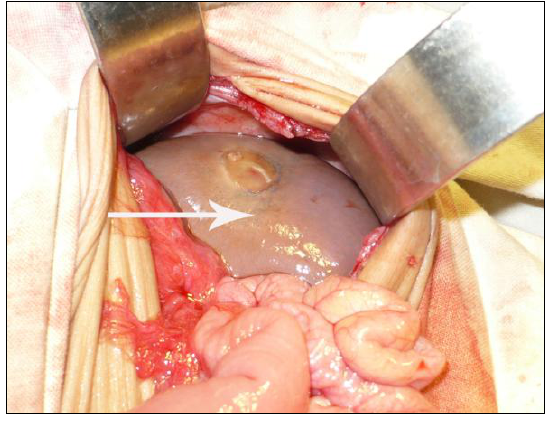
Figure 2: A grayish cyst in the abdomen.